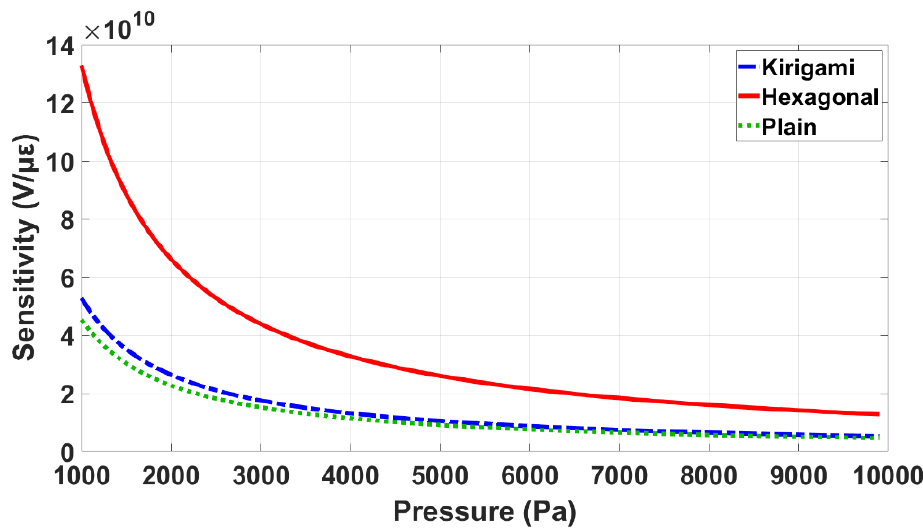
Figure 16. Sensitivity performance of the three simulated models in different pressure amplitudes.